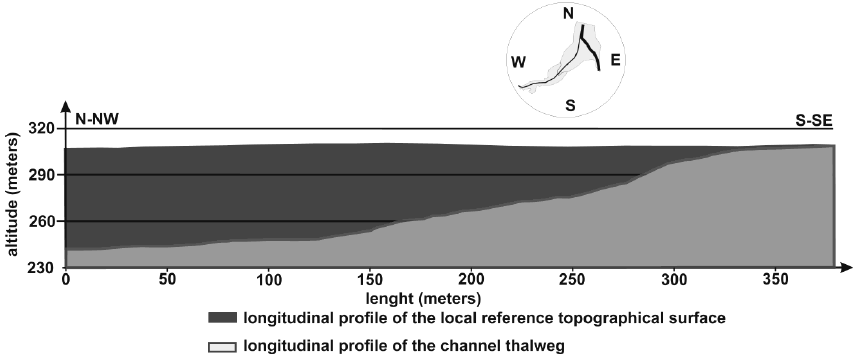
Fig. 12. Longitudinal profiles of the surface and river bed Cucuteni-Baiceni side gullies in 2010